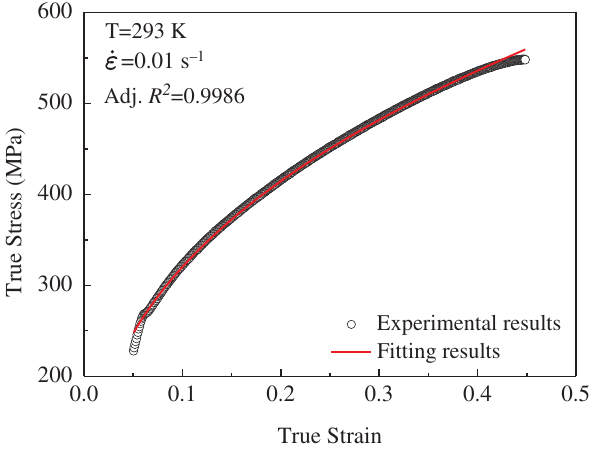
Figure 6: The relationship between true strain and true